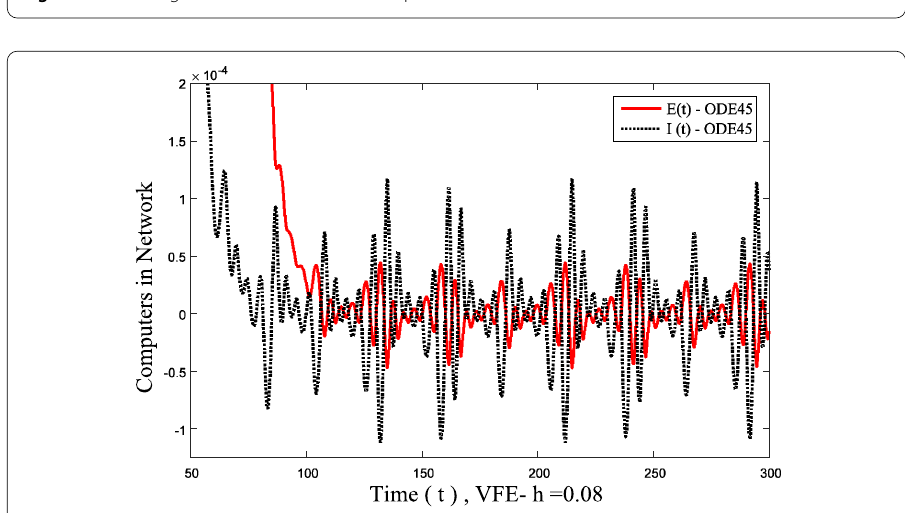
Figure 14 Convergence curves of ODE45 to VE point at h = 3.5